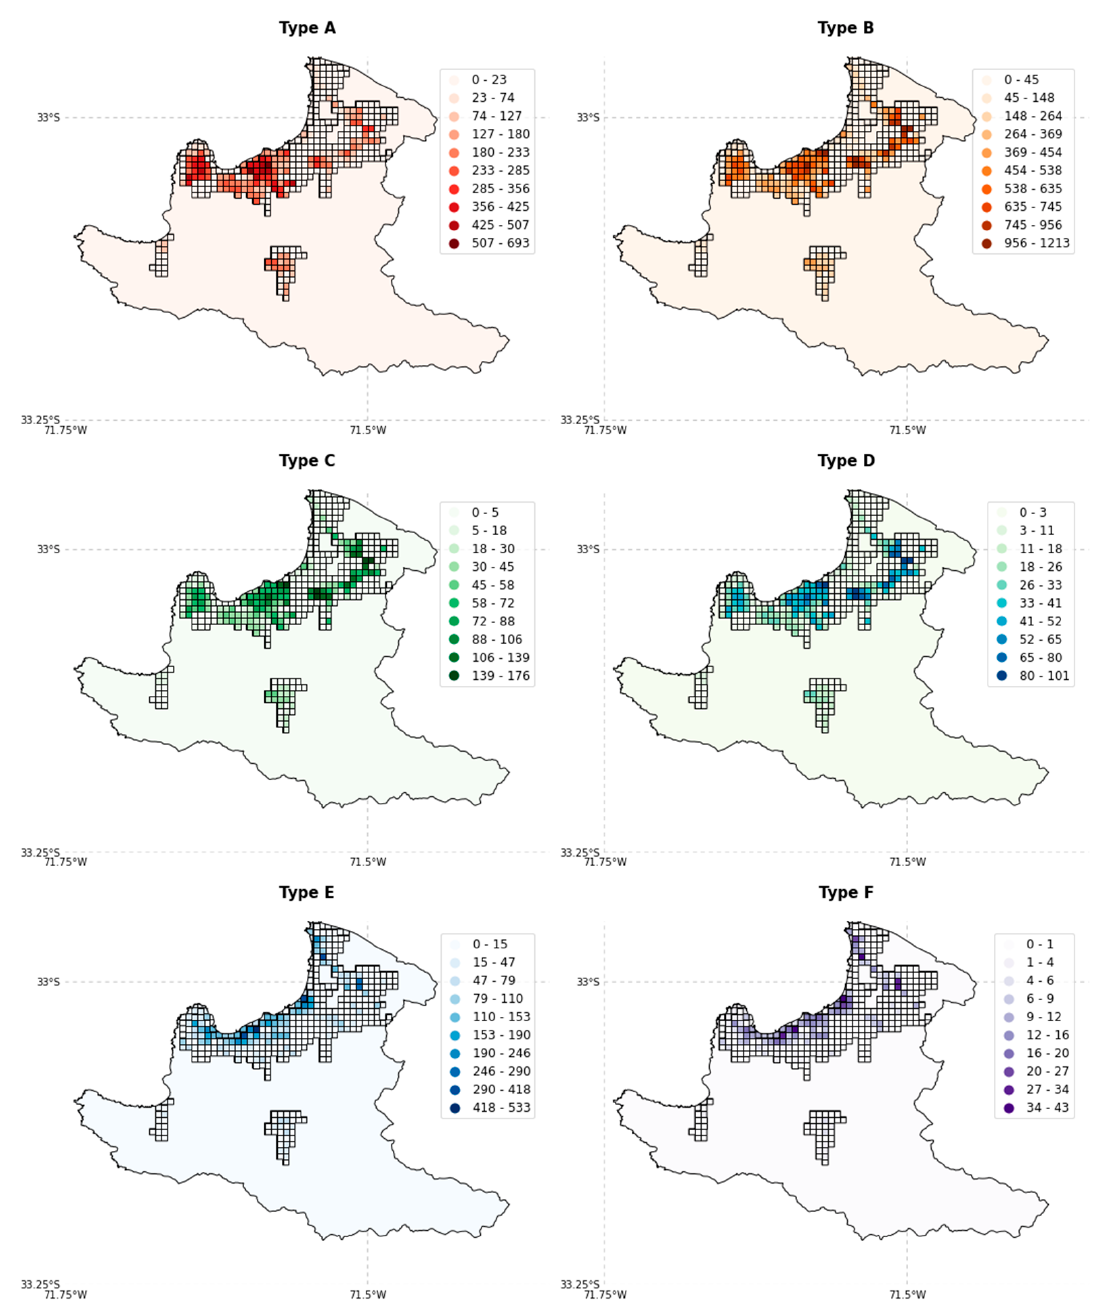
Figure 9. Spatial distributions of the building counts for the subcategories in the range A–F obtained from the probabilistic model in Valparaíso.